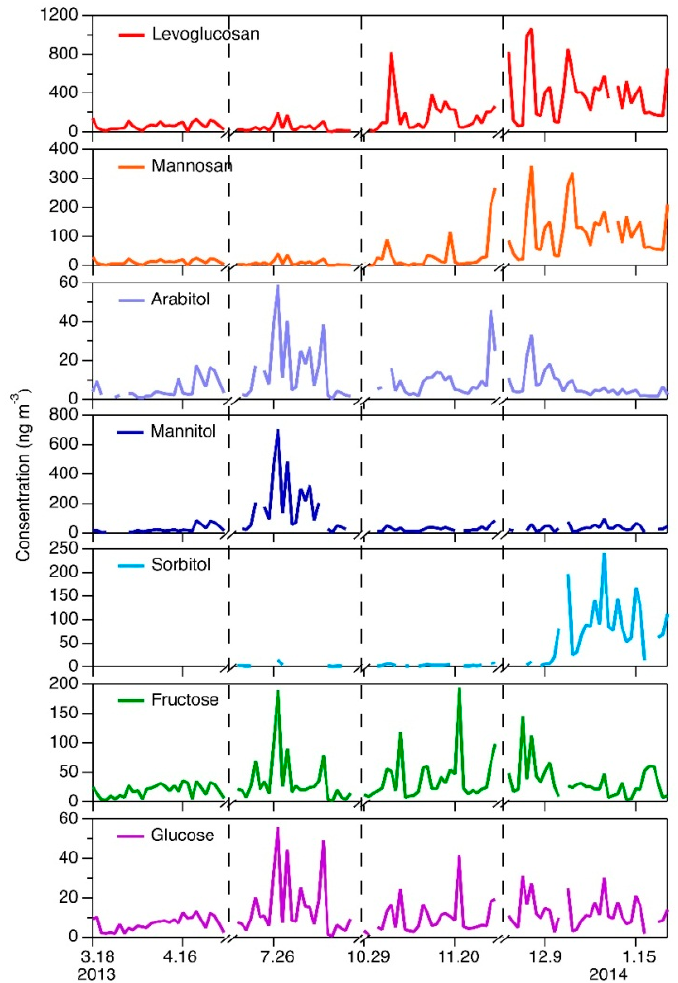
Figure 2. Daily concentrations of seven saccharides in PM 2.5 (The areas separated by dotted lines indicate the four seasons of spring, summer, autumn, and winter).